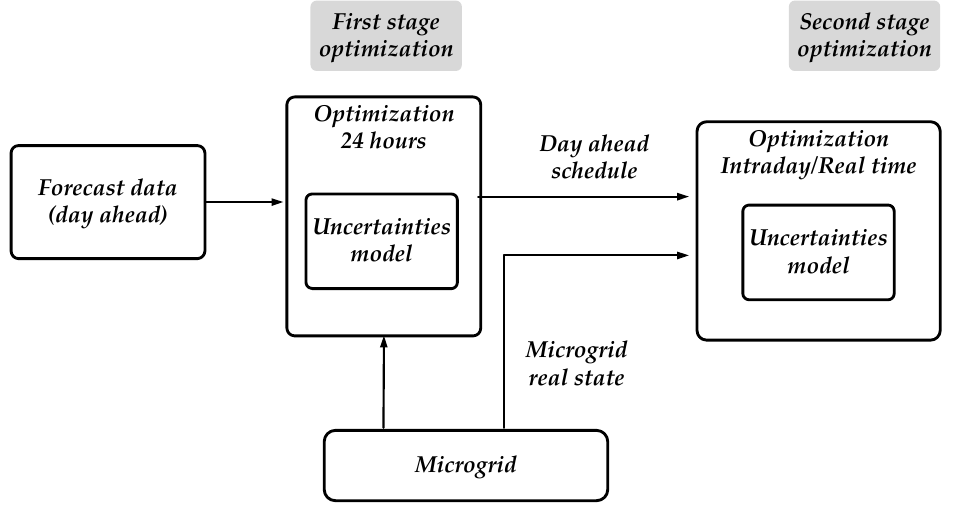
Figure 6. Two stages optimization block